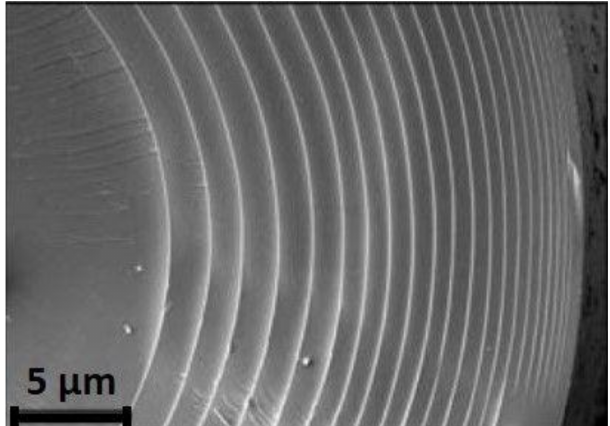
Figure 1. SEM of a cross-section through a typical spicule. Laminated structure composed of thin organic layers between silica layers [10]. Reprinted with permission from